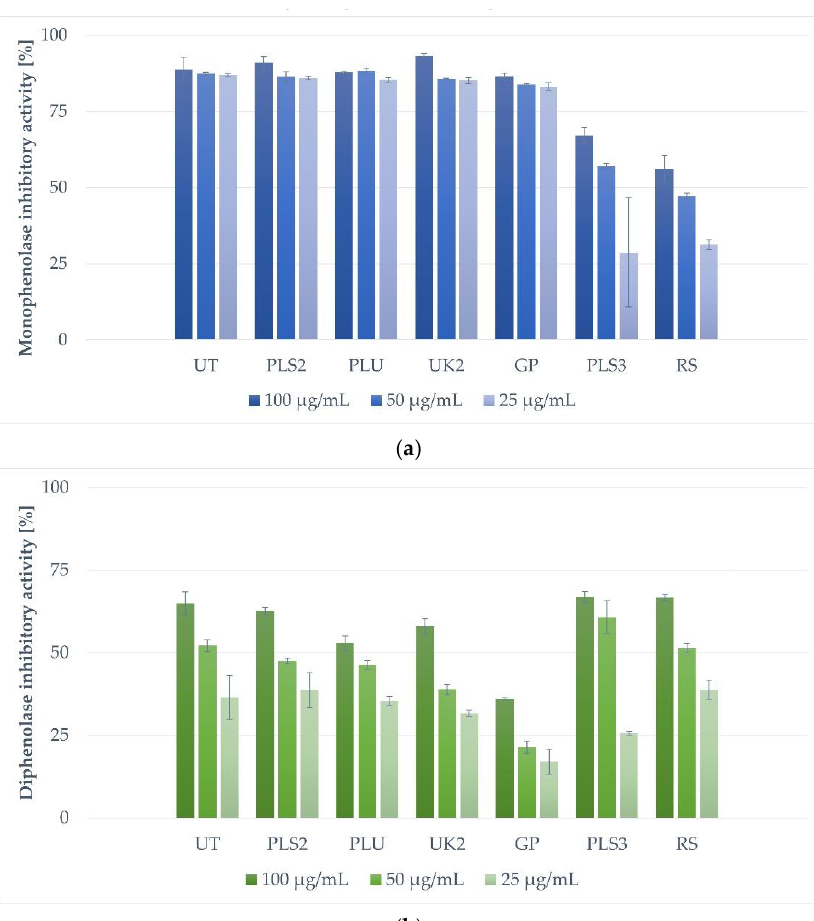
Figure 1. Inhibition of monophenolase ( a ) and diphenolase ( b ) by tested propolis extracts. Table legend: UK2 — Ukraine, Khmelnitsky Village; UT — Ukraine, Tarnopol; PLS2 — Poland, Lower Sile- sia; PLS3 — Poland, Lower Silesia; PLU — Poland, Lublin Region; GP — Greece, Parga; RS — Russia, Saratov Oblast.